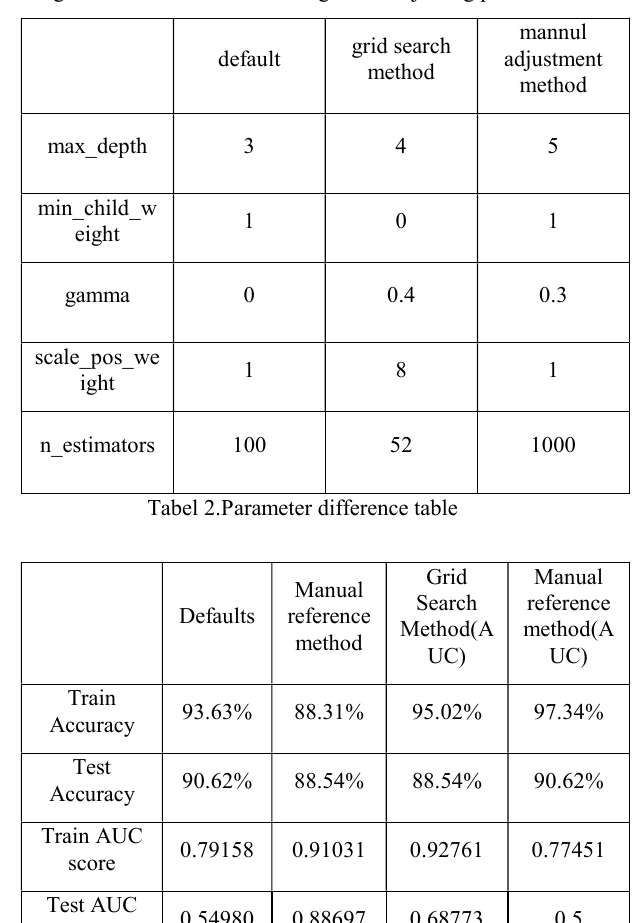
Figure 8.The result of the average after adjusting